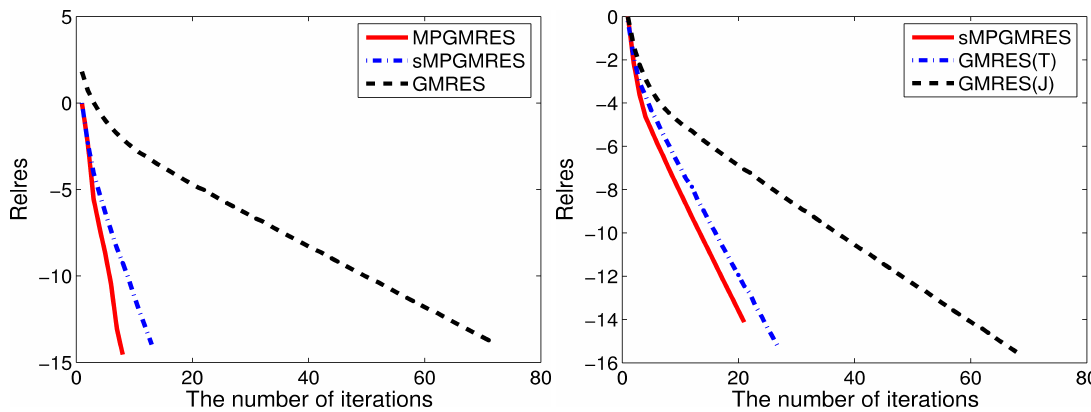
Fig. 2. Convergent histories of the MPGMRES, sMPGMRES and unpreconditioned GMRES for Example 4.1 when l 1 = 128 and l 2 = 128 (left). Convergence histories of the sMPGMRES, GMRES( T ) and GMRES( J ) for Example 4.1 when l 1 = 512 and l 2 = 512